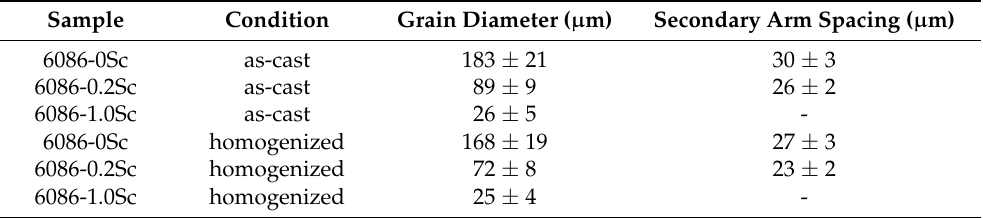
Table 2. Grain sizes in the as-cast condition of the investigated alloys according to ASTM E112.